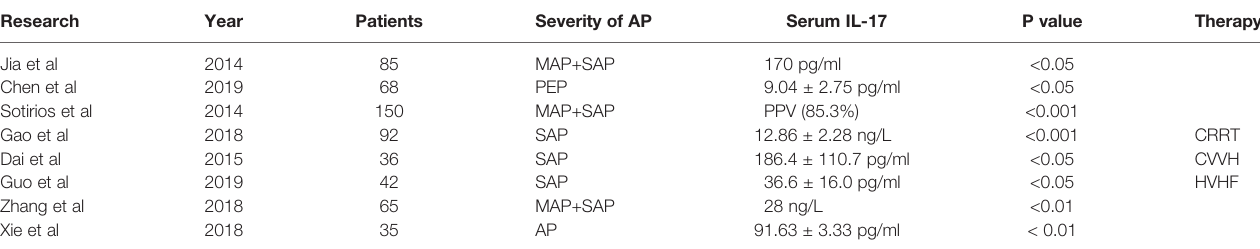
TABLE 1 | IL-17 as a novel biomarker of AP with current clinical results.